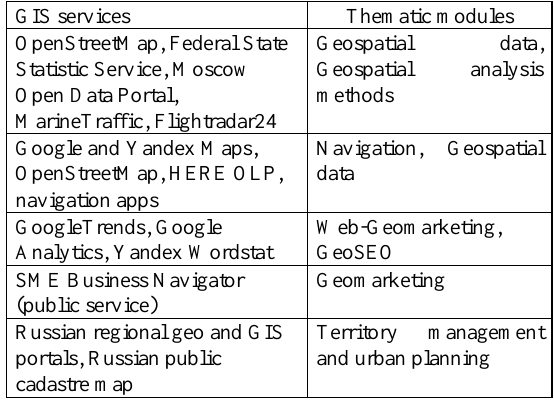
Table 3. GIS services used in educational process (see related links in